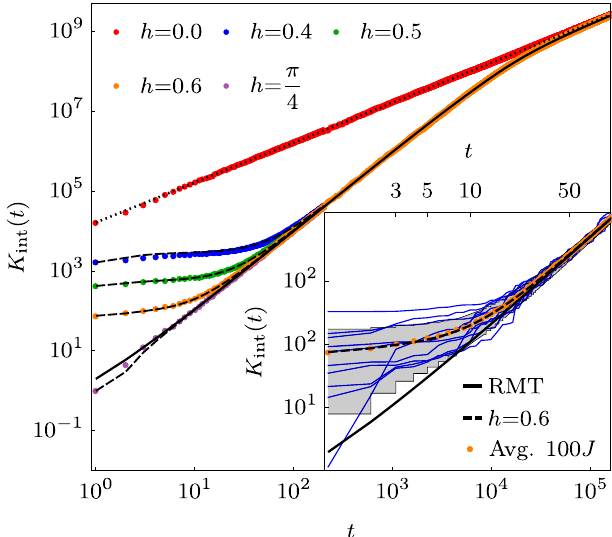
FIG. 1. Time-integrated spectral form factor for the kicked Ising model for up to ten Heisenberg times and at four different values of the transverse field h . The black dashed lines show predictions of the random phase model, while dotted (solid) lines give the Poissonian (RMT OE) result. The colored dots show numerical data averaged over 100 realizations of J sampled uniformly in the interval [5.5, 55], for the kicked Ising model introduced in Eq. (26). In the inset we show that averaging is only necessary for very short times. Thin blue lines are particular realizations of the model for J ¼ 10 ; 11 ; … 19 and the shaded area shows the second to ninth decile assuming exponential distribution for realizations of K ð t Þ resulting in a hypoexponen- tial distribution for the integrated spectral form factor. Other parameters are fixed to l ¼ 14 , a ¼ 1 , b ¼ 5 , α ¼ 1 . 5 .